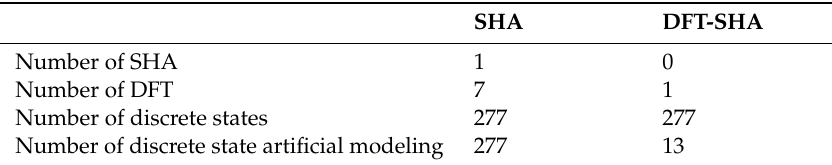
Figure 3. Dynamic Fault Tree (DFT) of the flywheel system. Table 2. Comparison between traditional methods and DFT- Stochastic Hybrid Automaton (SHA) method.